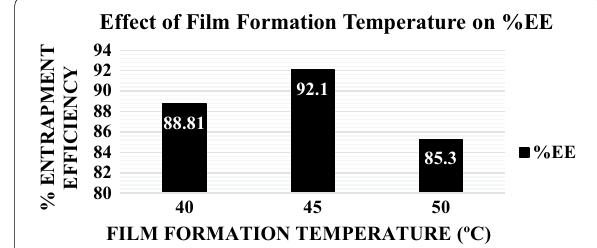
Fig. 4 Graphical comparison of effect of film formation temperature on %EE